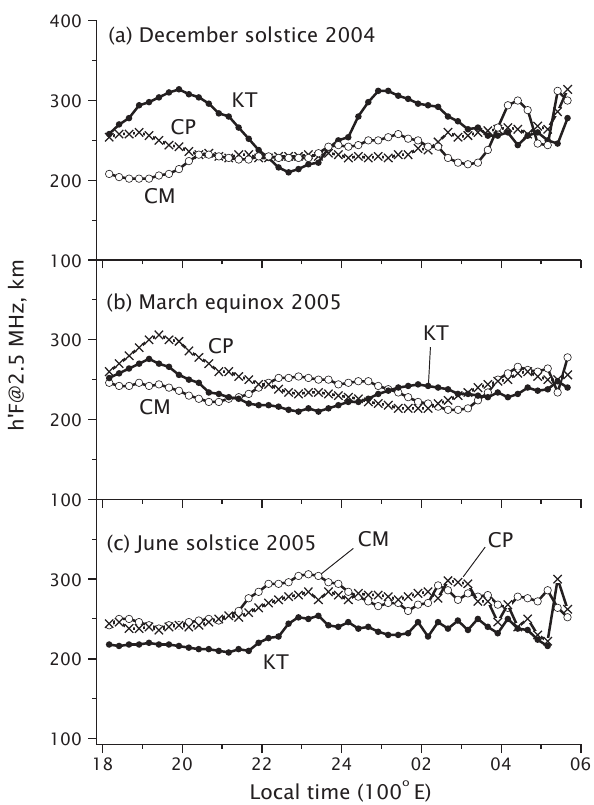
Fig. 9. Median values for the December solstice (a) , March equinox (b) , and June solstice (c) for Chiang Mai (CM), Chumphon (CP), and Kototabang